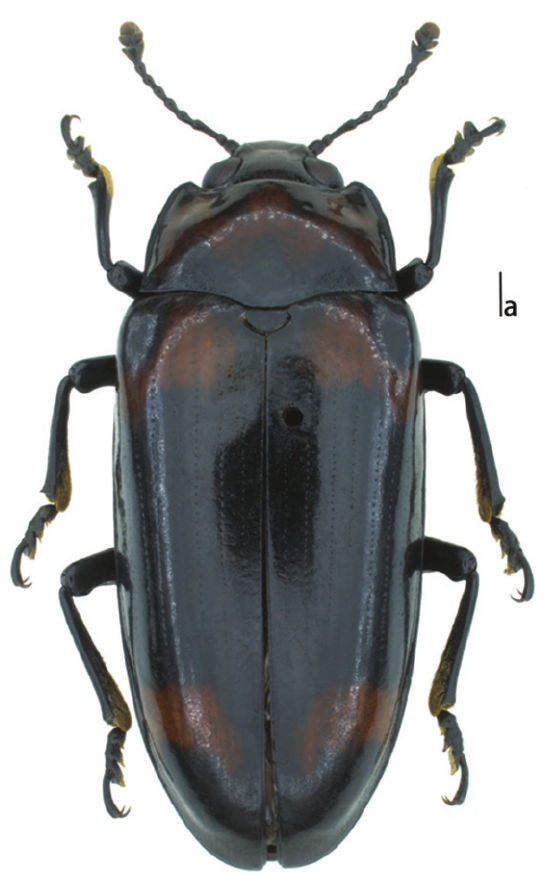
Prosternum (Fig. 16) sparsely punctured laterally, with some shallow and oblique rugulae; a depression in the middle area; surface with short golden setae. Prosternal process triangular, produced into a blunt point at apex, emarginated on pos- terior border, sparsely punctured on point, with longitudinal rugulae at front. Prosternal femoral lines converging anteriorly and slightly exceeding to the front edge of coxae. Scutellum almost triangle, posterior angle blunt, and surface with fine and sparse